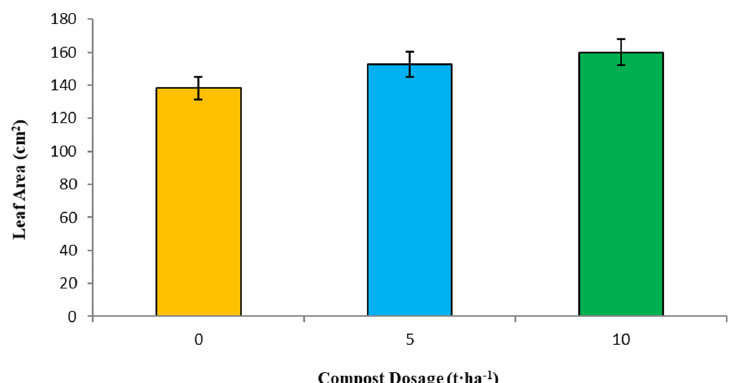
Figure 7. Effect of compost dosage on leaf area of okra at 8 weeks. 0, 5 and 10 represent compost dosage Data in the interaction analysed with Least Squares Means, and means separated with